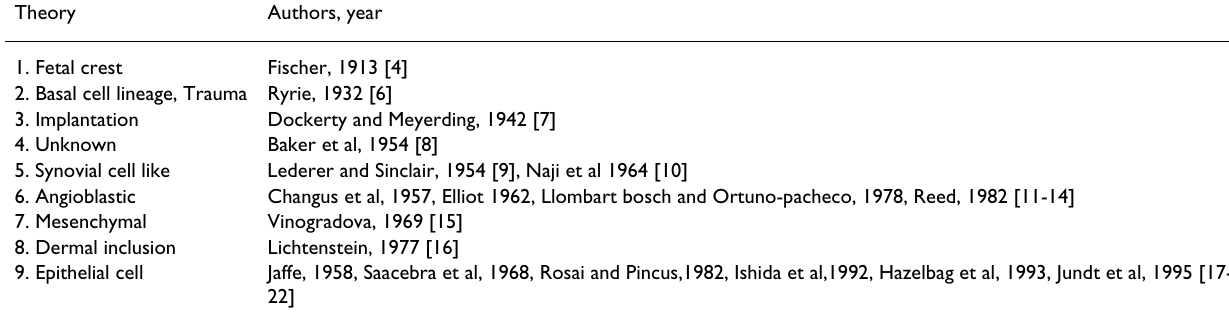
Table 1: Theories of origin of Adamantinoma